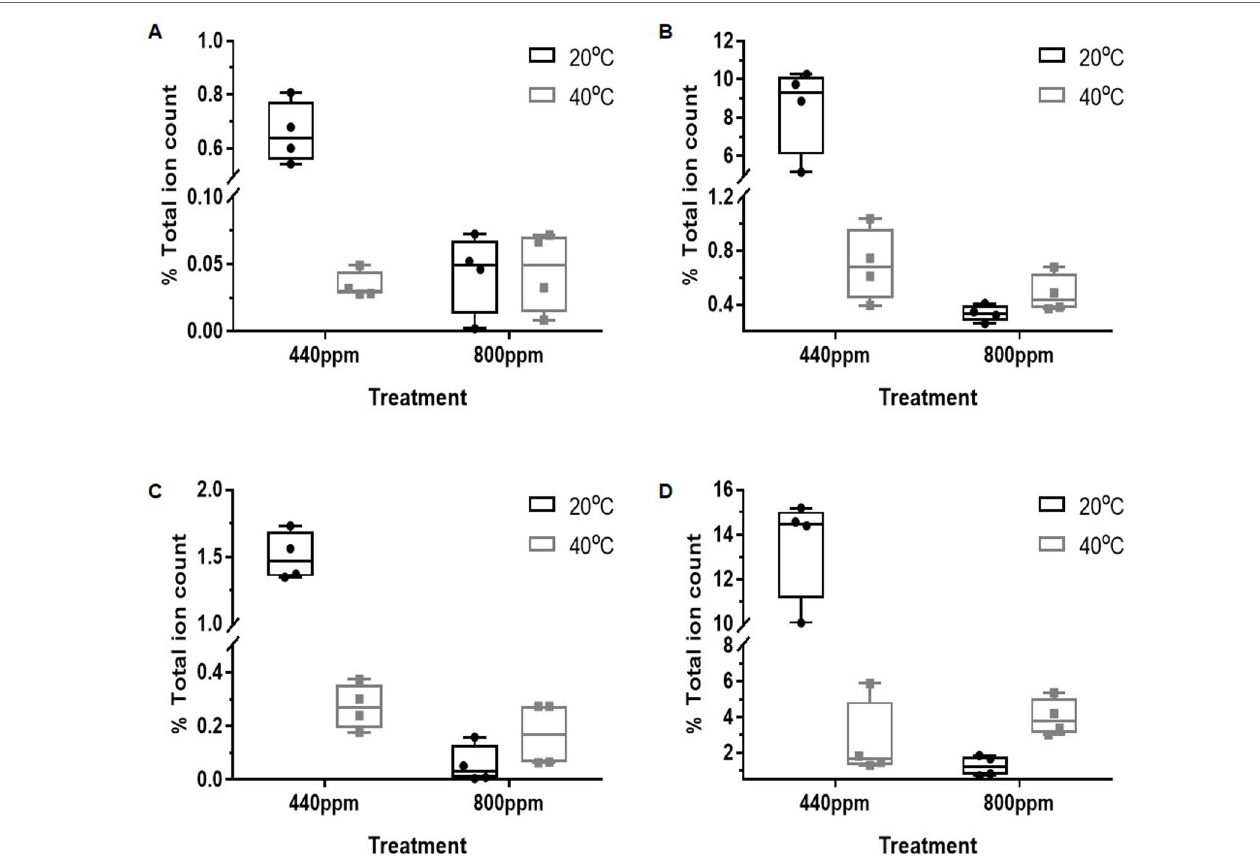
FIgURE 3 | Total % ion count of discriminatory mass bins ( m/z) from MALDI-ToF analysis of polar phase, negative ionisation mode. The mass bins represented are defined as containing a number of putatively identified secondary metabolites found in the Flavonoid biosynthesis pathway including the compounds: Apigenin, Cyanidin, Luteolin, and Quercetin. The graphs show less abundance of the %TIC of the secondary metabolites within the bins under the CO 2 and temperature treatments when compared to the control treatment. (A) (bin 269); (B) (bin 285); (C) (bin 301); and (D) (bin 447). Each point represents a pooled replicate per plant across the four treatments. Bars represent minimum and maximum